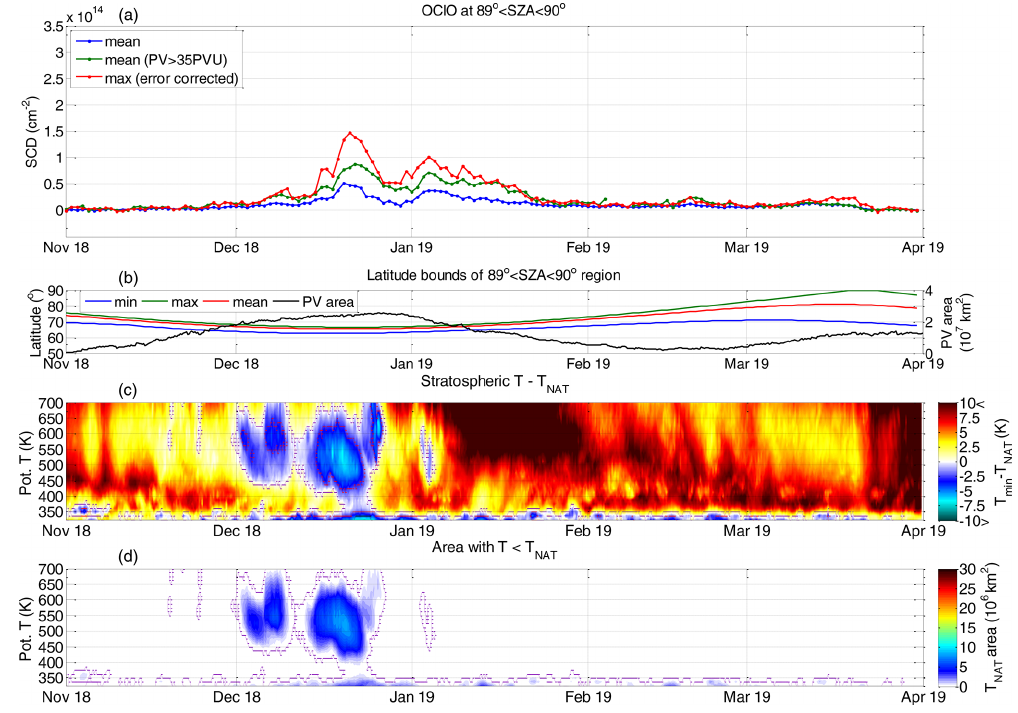
Figure 4. Same as Fig. 1 but for the Arctic winter